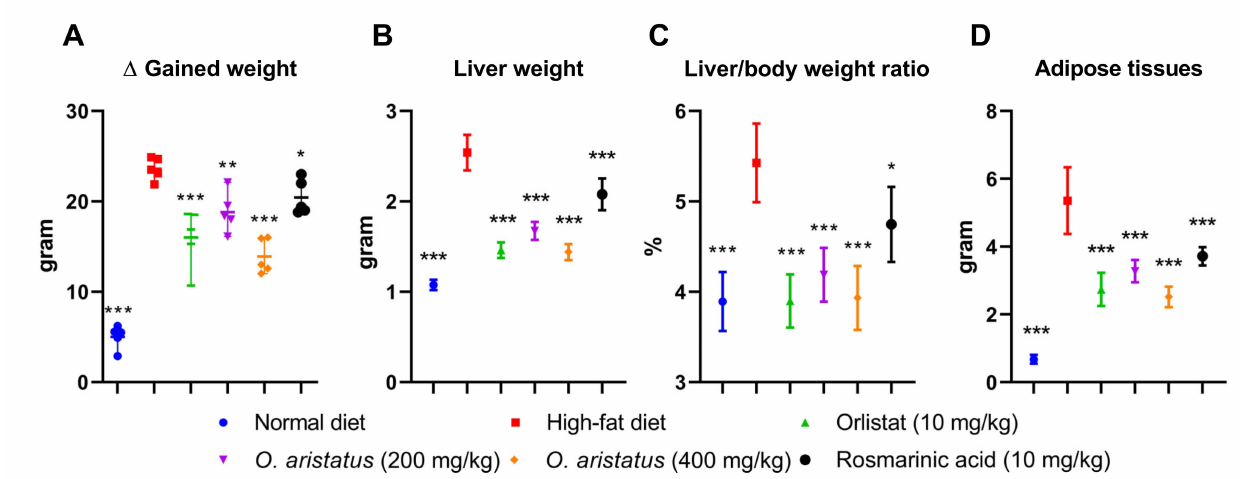
Figure 3. The effects of O. aristatus on NAFLD-related mice organs. ( A ), the difference in body weight between stat and end tome point of the experiment. ( B ), the liver weight at the end of the experiment. ( C ), the ratio of the liver weight to the final body weight. ( D ), the total weight of the adipose tissue. * p < 0.05, ** p < 0.01, *** p ≤ 0.001 compared to high-fat diet control group. The values were presented as mean ± SD, n =